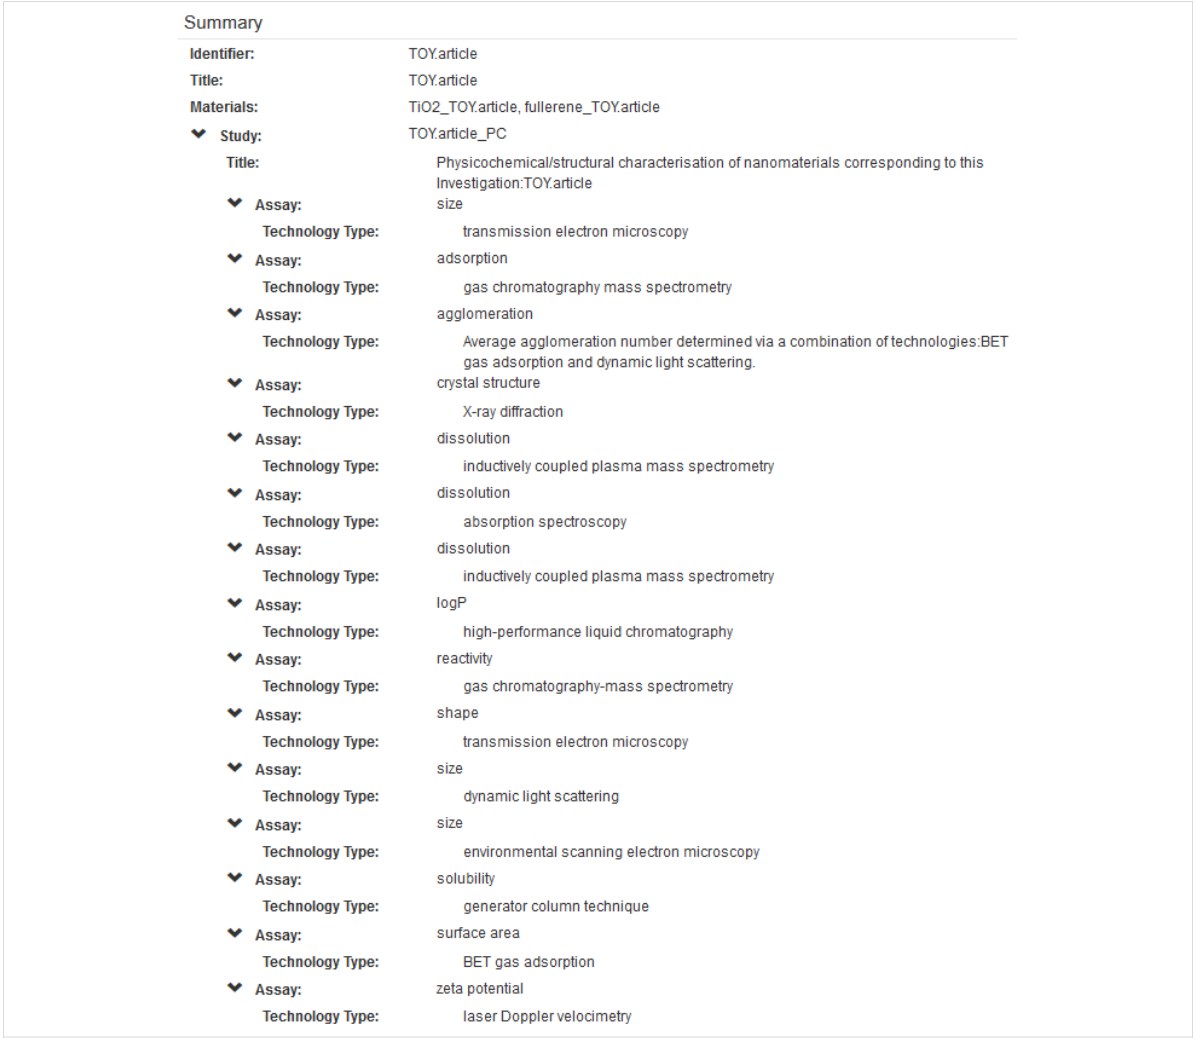
Figure 6: A summary of the physicochemical assay toy data recorded in the “Toy Dataset” (Supporting Information File 3), generated via the nanoDMS system as per Figure 5. This does not include the hypothetical chemical composition and nominal/vendor supplied data recorded in the Ma- terial files.